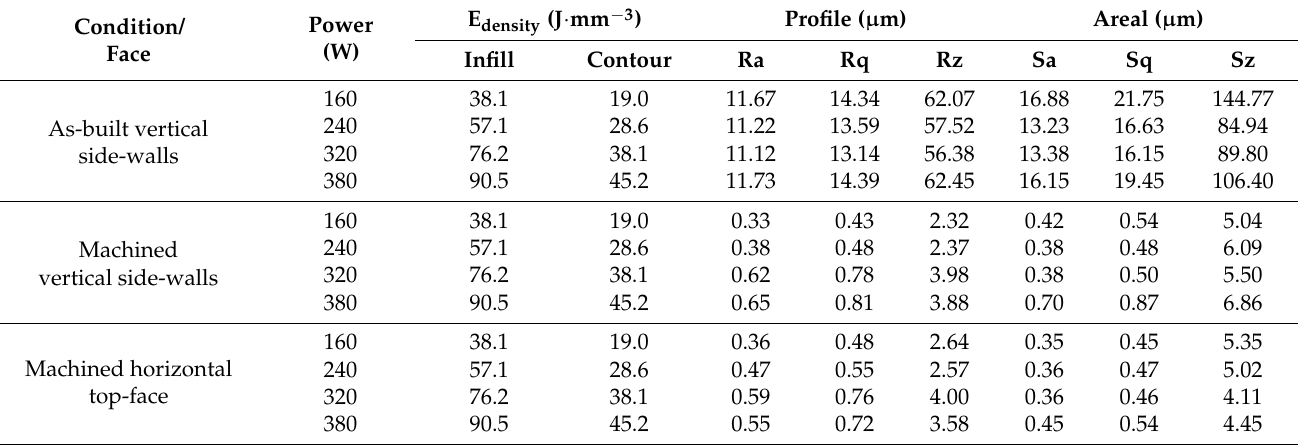
Figure 5. Contour plots of the geometric deviations on the ( a ) as-built (B) and ( b ) built-and-machined (B&M) surfaces of the four blocks fabricated at the different laser powers. Table 1. Profile and areal roughness parameters measured on the different vertical side-walls and horizontal top-faces of the four